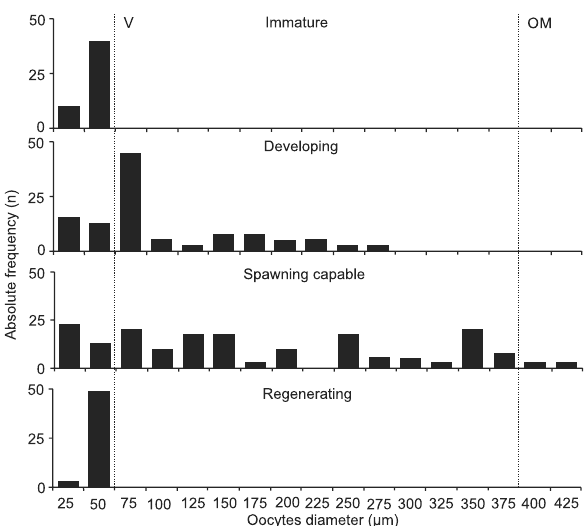
8Figure 7. Oocyte size-frequency distribution through subsequent phases of gonad development of Cynoscion leiarchus. Dashed line (V) indicate early vitellogenesis and (OM) indicate early oocyte